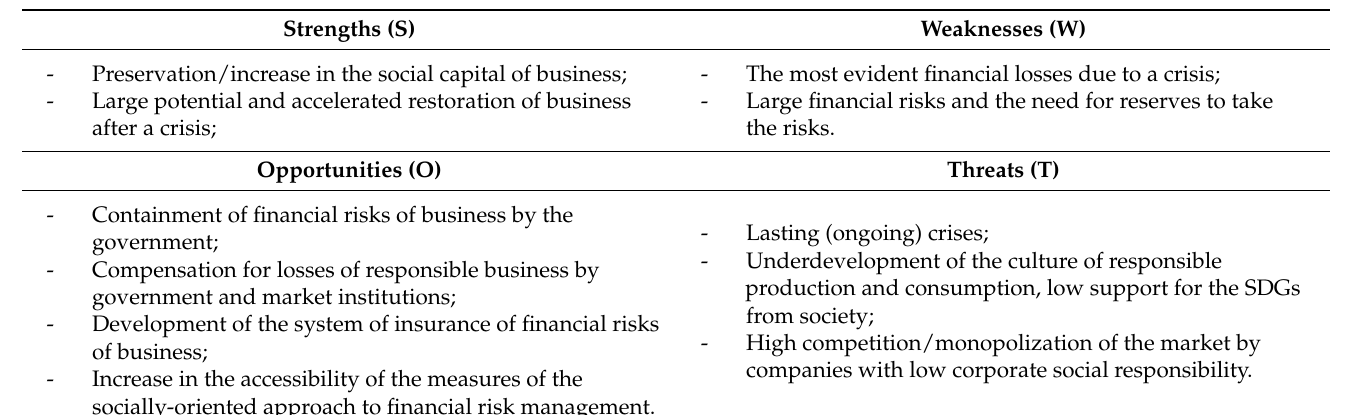
Table 8. SWOT analysis of the socially-oriented approach to financial risk management in en- trepreneurship in conditions of